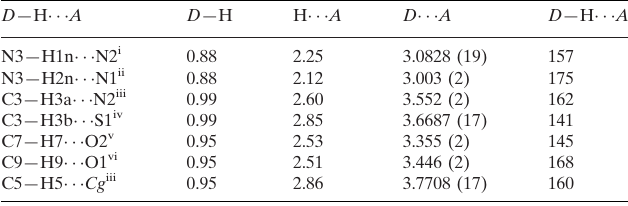
Hydrogen-bond geometry (A˚ , (cid:2)